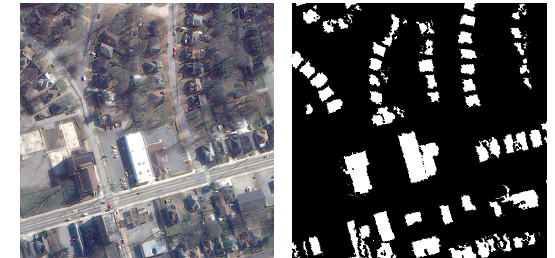
Figure 2. WorldView-2 image of Atlanta from the US3D dataset with the associated building labels